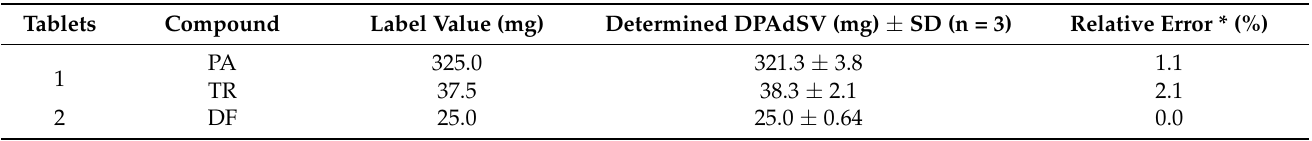
Table 4. The results obtained during the determination of PA, DF, and TR in pharmaceutical formulations at the aSPCE/SDS.